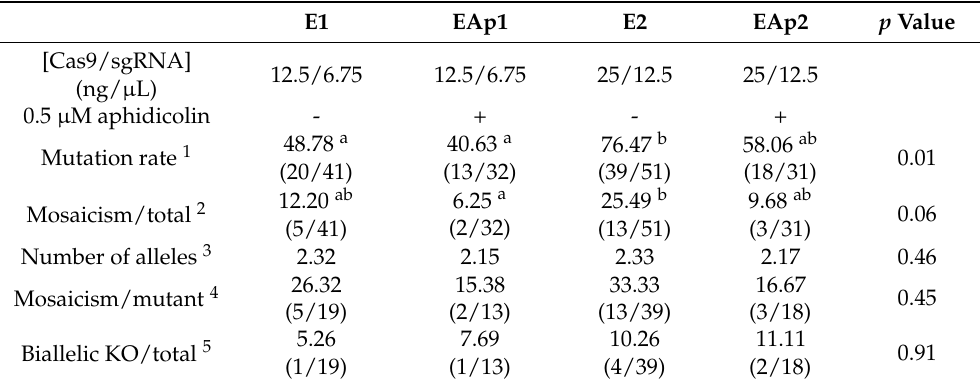
Table 2. Effect of ribonucleoprotein (Cas9/sgRNA) concentration and aphidicolin on mutation parameters expressed as mean ± SEM.